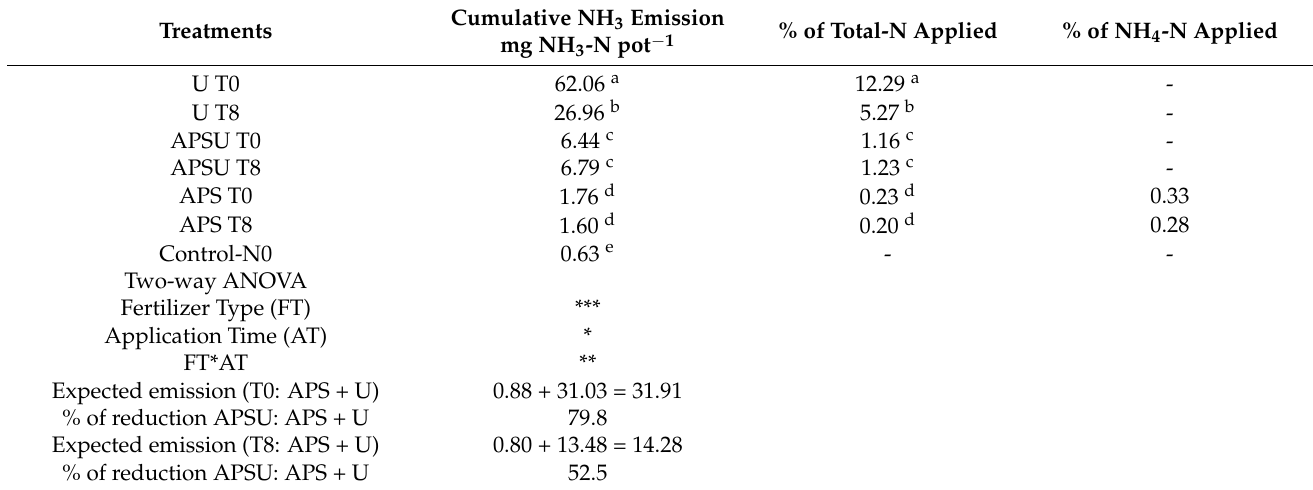
Table 4. Cumulative NH 3 emissions (mg NH 3 -N pot − 1 ) as a percentage of total-N and NH 4 -N applied (excluding control emission), two-way ANOVA, the expected NH 3 -N emissions considering the contribution of 50% from each one of the components of the mixture (APS + U at T0 and T8), and the percentage of emission reduction observed compared to expected. Values followed by different letters, in the same column, are significantly different based on the Tukey test (mean, n =